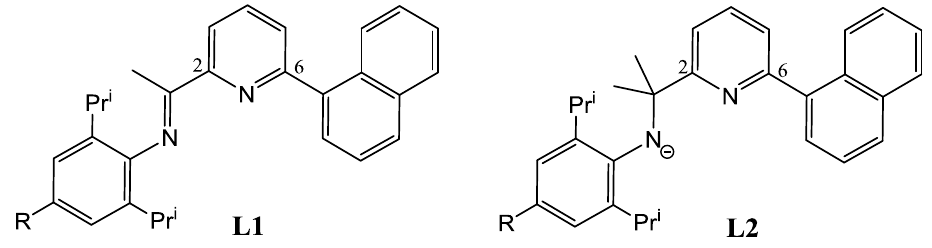
Figure 1. 2-Imino-6-(1-naphthyl)pyridine ( L1 ) and monoanionic 2-(amido-prop-2-yl)-6- (1-naphthyl)pyridine ( L2